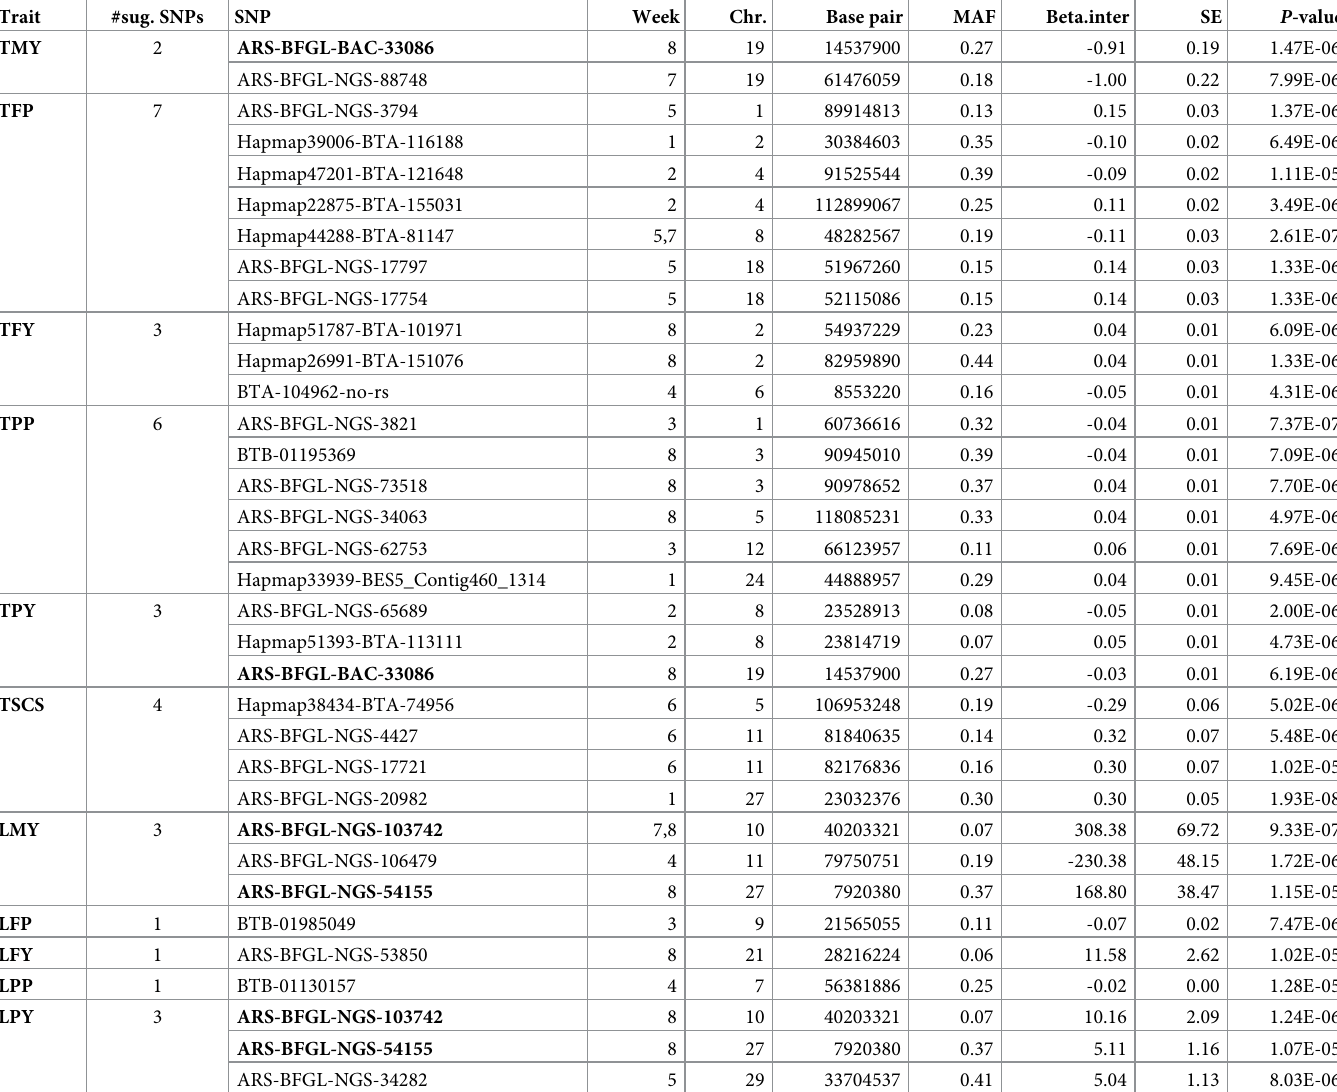
Table 4. SNPs with suggestive interaction effects on first test-day milk yield (TMY), fat percentage (TFP), fat yield (TFY), protein percentage (TPP), protein yield (TPY) and somatic cell score (TSCS), and on lactation milk yield (LMY), lactation fat percentage (LFP), lactation fat yield (LFY), lactation protein percentage (LPP) and lactation protein yield